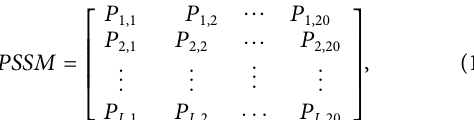
Frontiers in Bioengineering and Biotechnology |